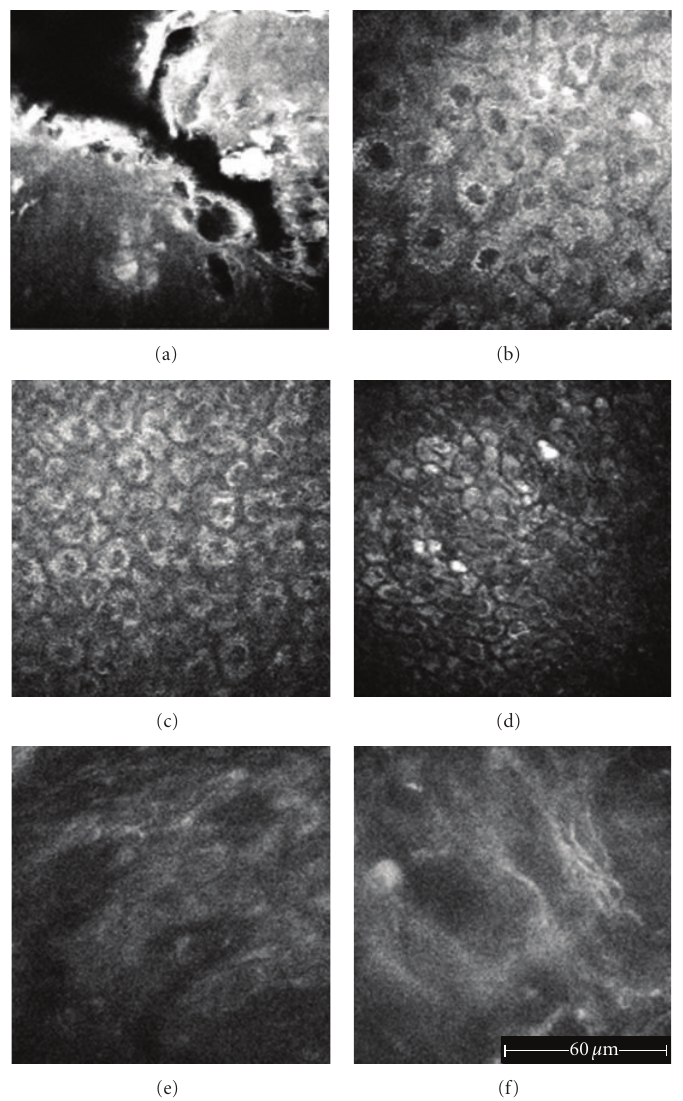
Figure 1: In vivo healthy skin. Images of the epidermis are acquired by means of the multiphoton laser microscope DermaInspect (JenLab GmbH, Jena, Germany) at a 760 nm excitation wavelength. (a) Stratum corneum, 0 μ m depth: strong autofluorescence coming from keratin and corneocytes, hexagonal-shaped flat cells. (b) Stratum granulosum, 20 μ m depth: large keratinocytes showing strong cytoplasmatic autofluorescence due to the presence of keratohyalin granules, NADPH, and keratin; the nuclei appear dark because they contain less fluorophores than the cytoplasm. (c) Stratum spinosum, 30 μ m depth: smaller keratinocytes and increased cellular density. (d) Stratum basale, 40 μ m depth: the keratinocytes are small, polygonal-shaped, and with dark nuclei. (e) Dermal papillae, 55 μ m depth: they are visible beyond the dermal-epidermal junction as oval-shaped, dark areas with a fluorescent contour, corresponding to a transversal section of the rete ridges surrounded by fluorescent basal cells. (f) Dermis, 85 μ m depth, 800 nm excitation wavelength: bright autofluorescence coming from fibrous structures corresponding to collagen and